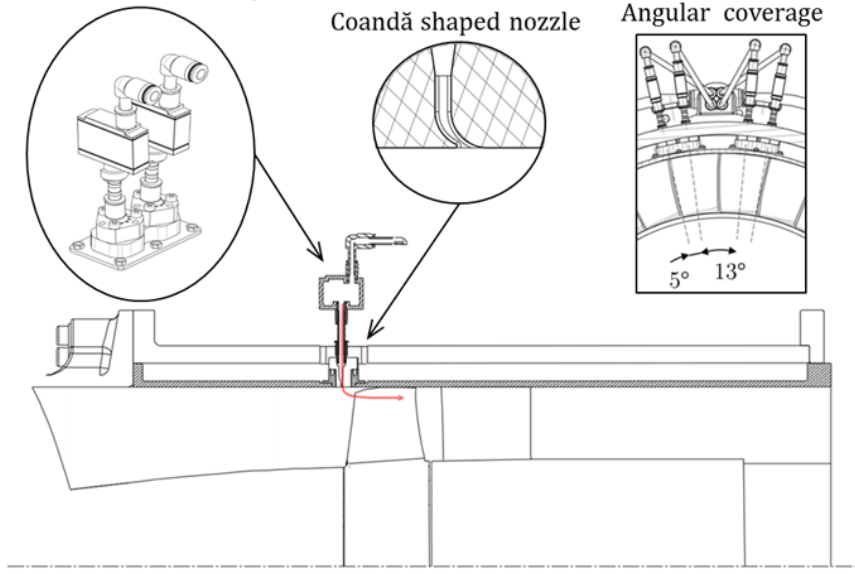
Figure 2. Active flow control system description.